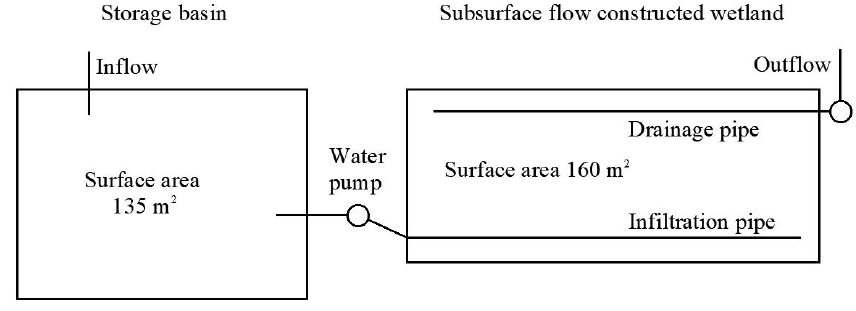
Fig. 1. Schematic drawing of the storm water treatment system at the Mezaciruli